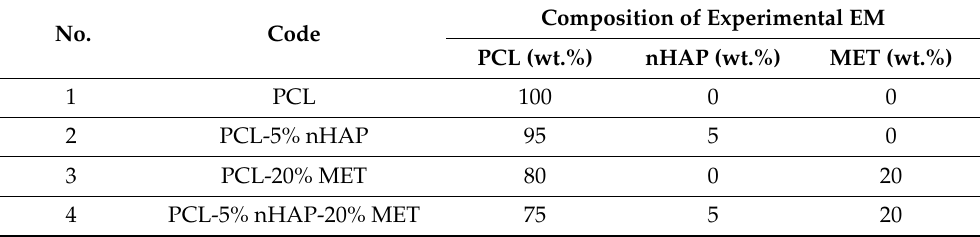
Table 1. The composition of experimental electrospun membranes (EMs). Composition of Experimental EM No. Code PCL (wt.%) nHAP (wt.%) MET